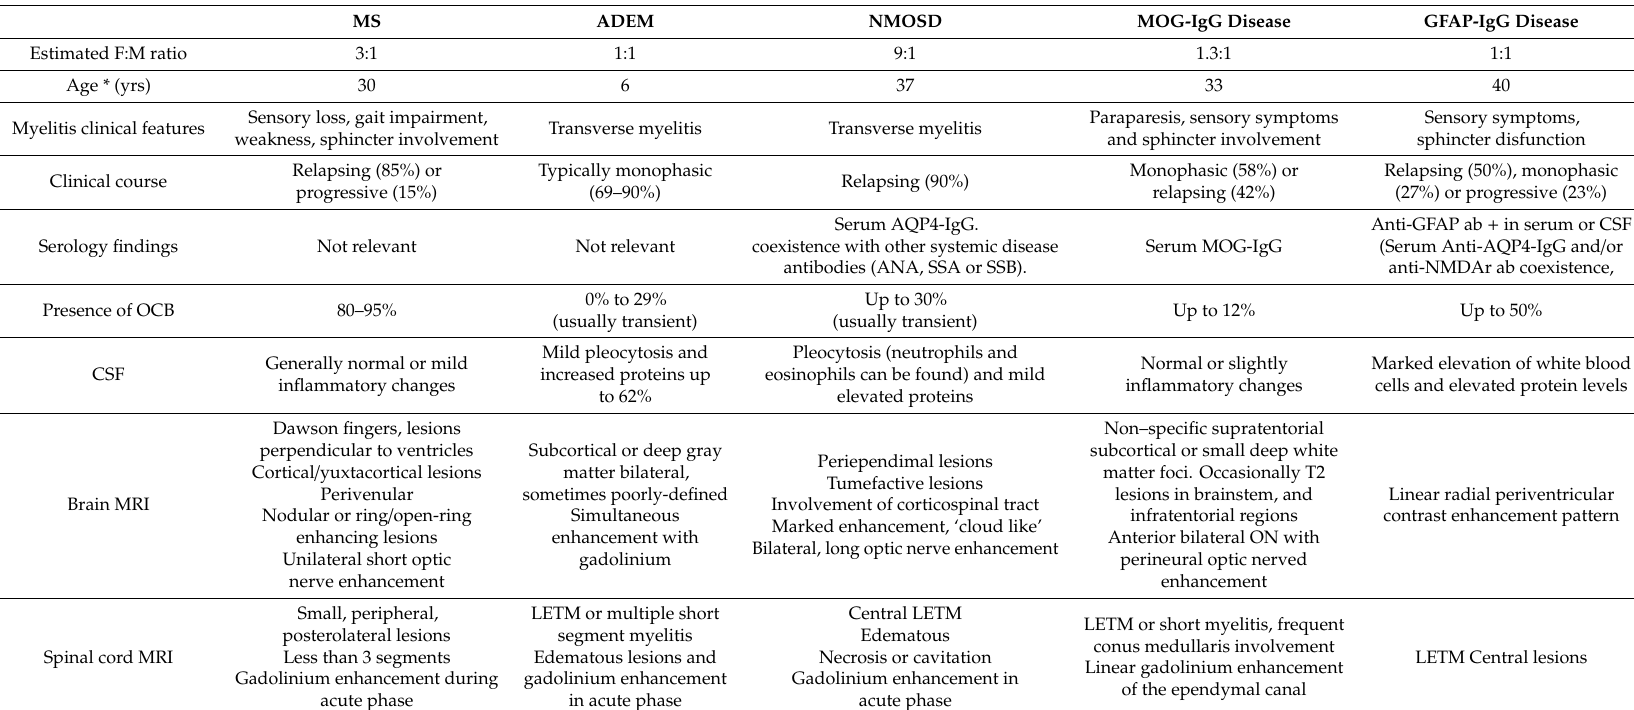
Table 1. Main features in demyelinating myelopathies of di ff erent